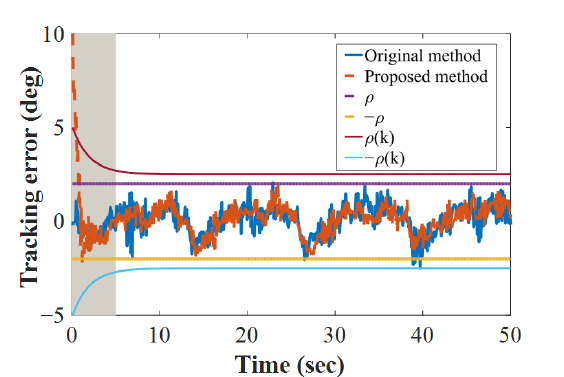
Figure 15. Experimental result (tracking